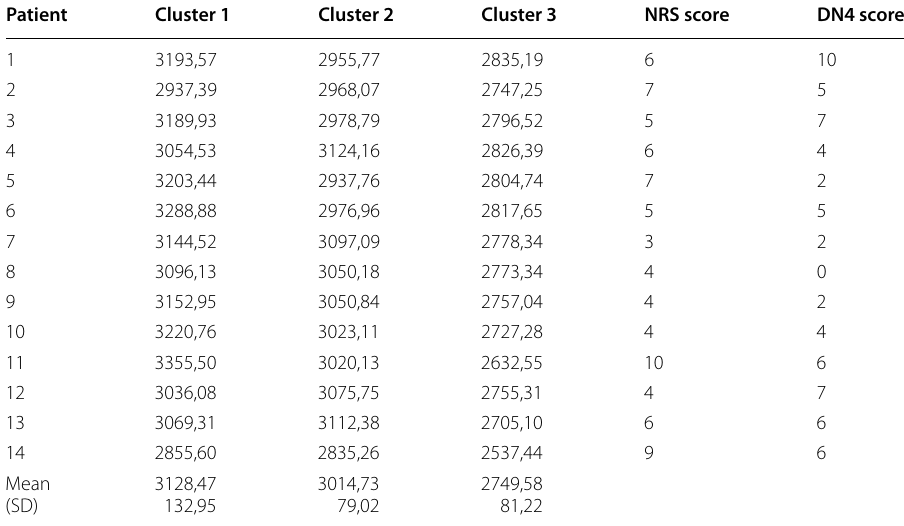
Table 3 Correlation between individual rCBF changes and NRS and DN4 pain